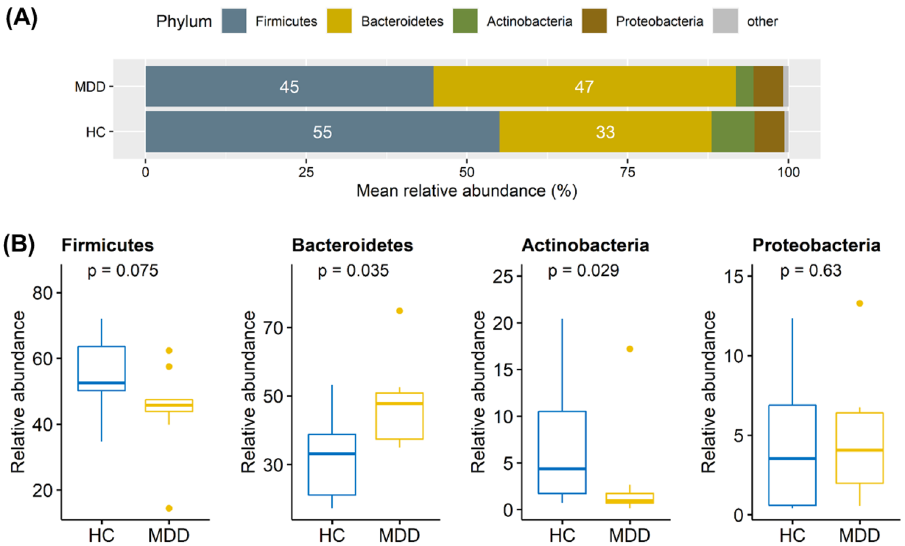
Figure 1. Microbiota composition at the phylum level. ( A ) Firmicutes and Bacteroidetes were the most dominant phyla within the groups, followed by Actinobacteria and Proteobacteria. ( B ) Two phyla Bacteroidetes and Actinobacteria significantly differed between the HC and MDD groups.